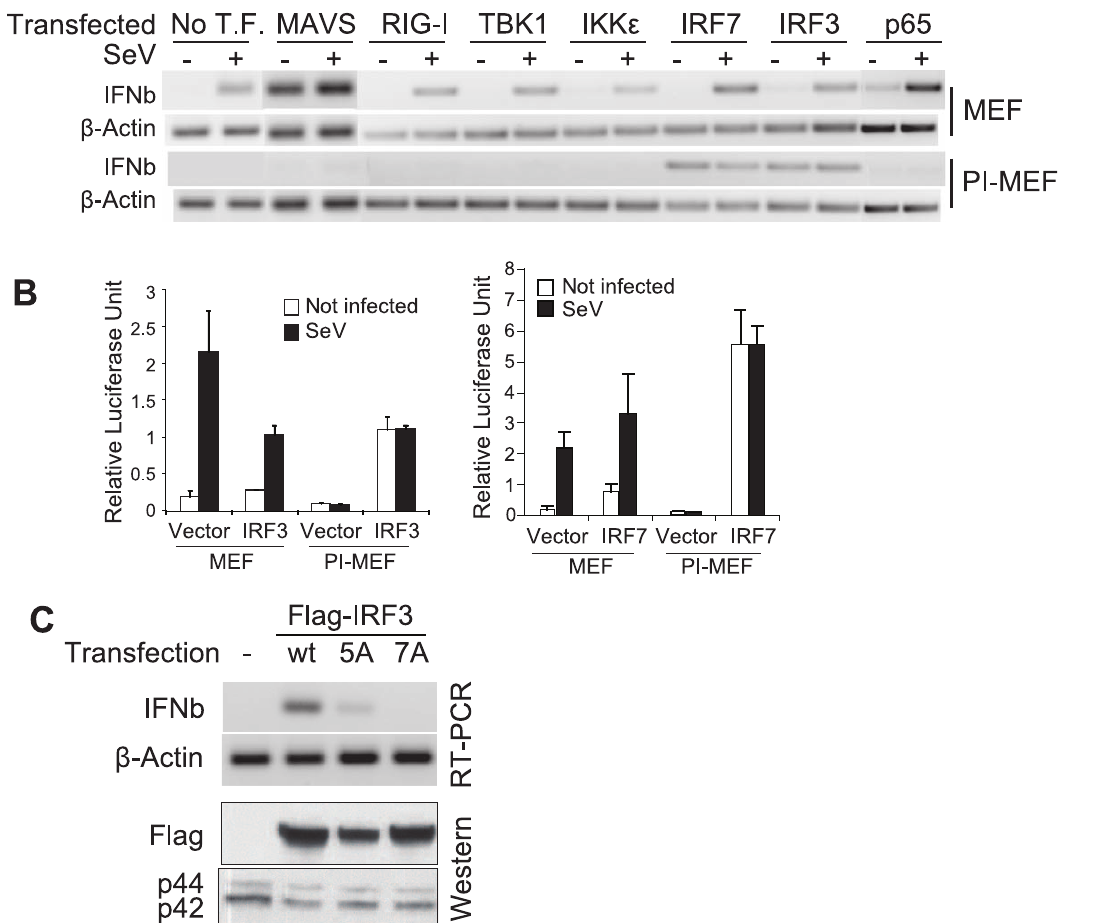
Figure 3. The block to IFN b activation in PI-MEFs is at the level of IRF3/7. A . IRF3/7 transfection activates IFN b gene expression in PI-MEFs. Control MEFs or PI-MEFs were transfected with plasmids encoding RIG-I, MAVS, TBK1, IKK e , IRF3, IRF7 andp65 genes. 24 hrs later,cells were infected with SeV for additional 6 hrs and RNA harvested for the analysis of IFN b and b -Actin expression by RT-PCR. B . IRF3/7 activates an IFN b gene reporter in PI- MEFs. Control MEFs or PI-MEFs were transfected with the IFN b promoter firefly luciferase reporter gene together with IRF3 or IRF7 expression constructs. A renilla luciferase construct was also included for transfection reference. 24 hrs later, the cells were infected with SeV, and the luciferase activity measured one day later. C . IRF3 mutations rendering the protein defective for phosphorylation failed to activate IFN b expression in PI-MEFs. PI-MEFs were transfected with a Flag-tagged wild type IRF3 expression construct or 5A and 7A mutants for 30 hrs. RNA and protein were harvested and analyzed for the expression of IFN b and b -Actin by RT-PCR, or probed with anti-Flag and MAP kinase p42/p44 antibodies by western blot